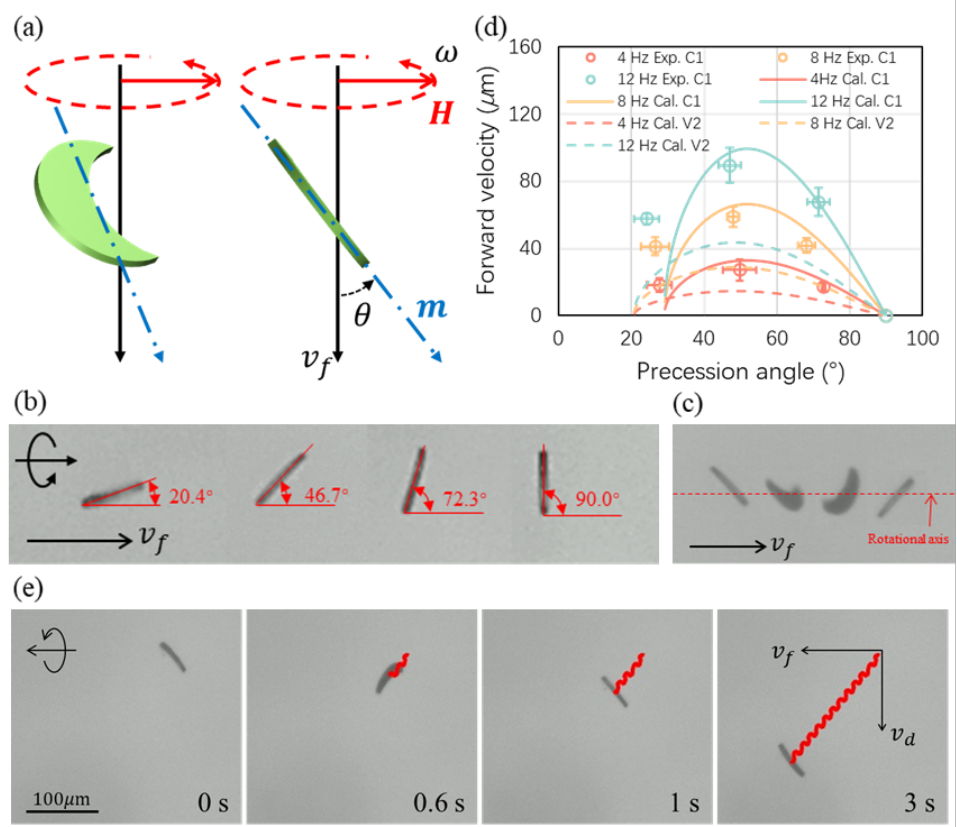
Figure 4. ( a ) Swimming motion of crescent-shaped and V-shaped microswimmer. The angle depicted in the figure is the precession angle; ( b ) Different swimming motions in experiments; ( c ) Swimming trajectory of a crescent-shaped microswimmer; ( d ) The effect of swimming motion or precession angle on forward swimming velocity under the different frequency of the rotational magnetic field; ( e ) Swimming with precession angle of 45 ◦ of a crescent-shaped microswimmer during a half